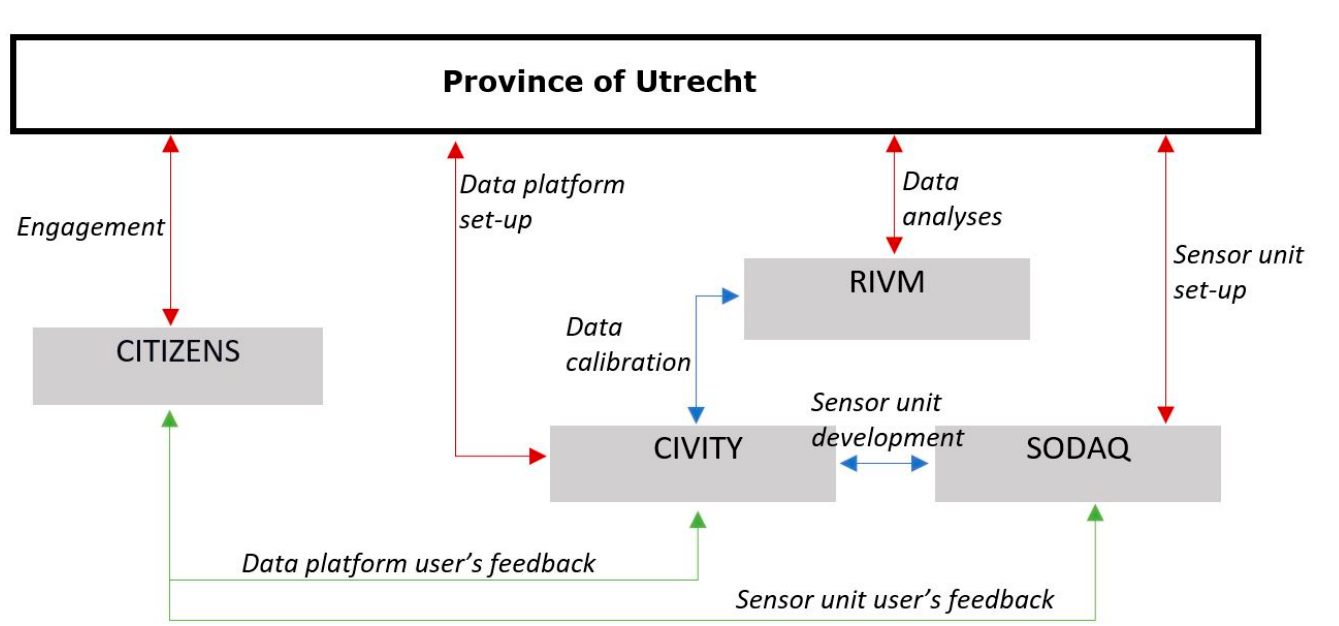
Figure 3. Data flow in the Sniffer bike project.